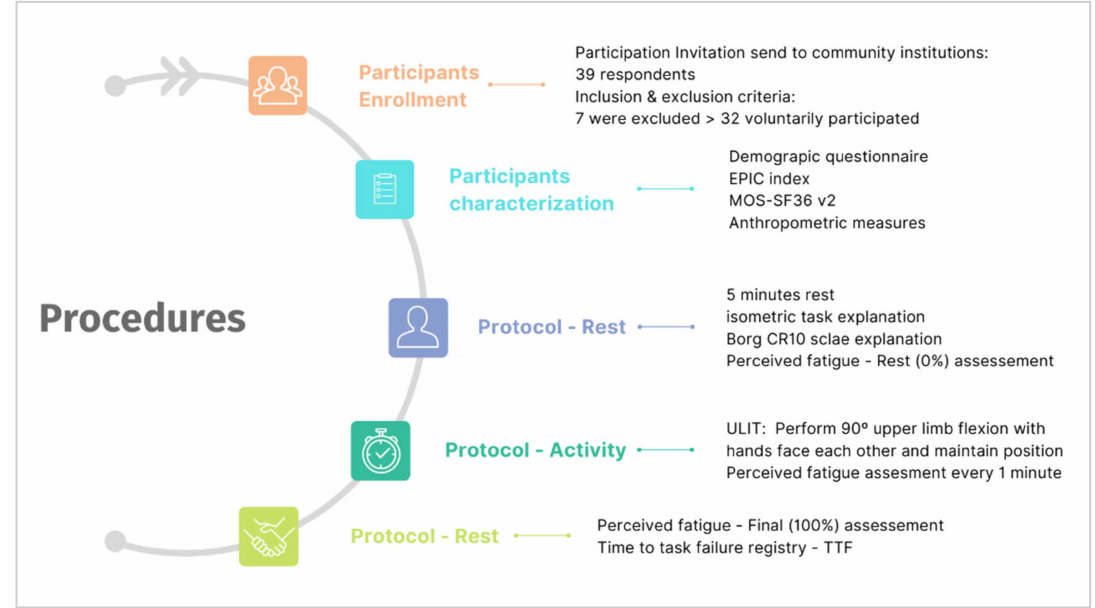
Figure 1. Sampling and protocol process